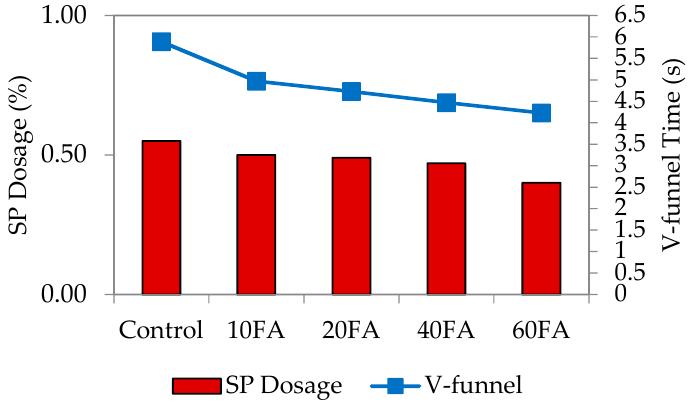
Figure 5. V-funnel time and SP dosage at w/b 0.35.